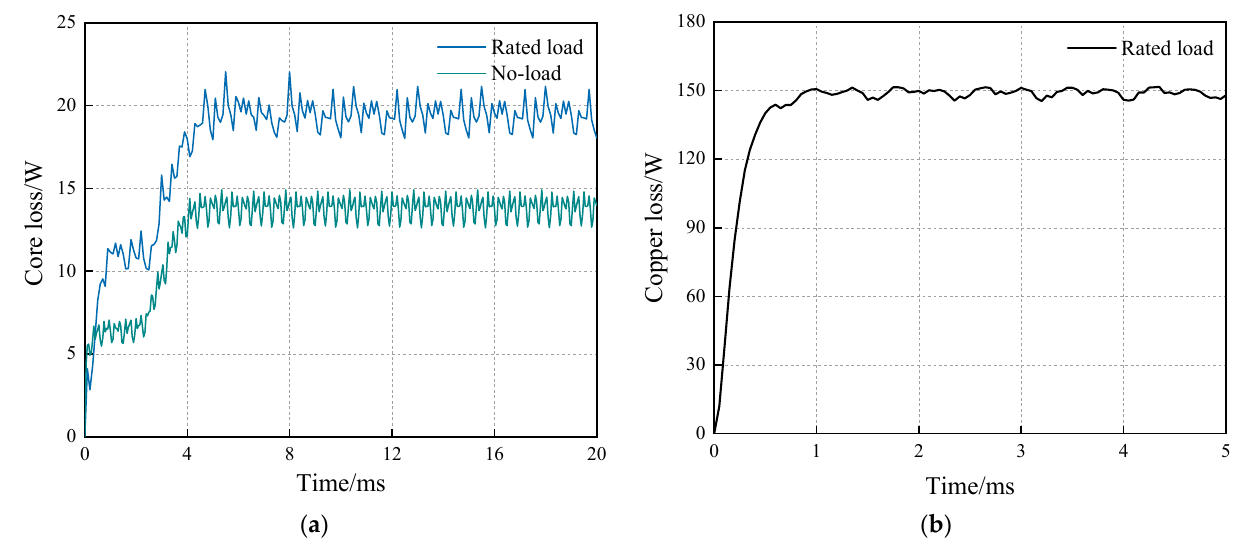
Figure 22. Loss of the hybrid excitation generator. ( a ) Core loss of the generator; ( b ) copper loss of the generator.